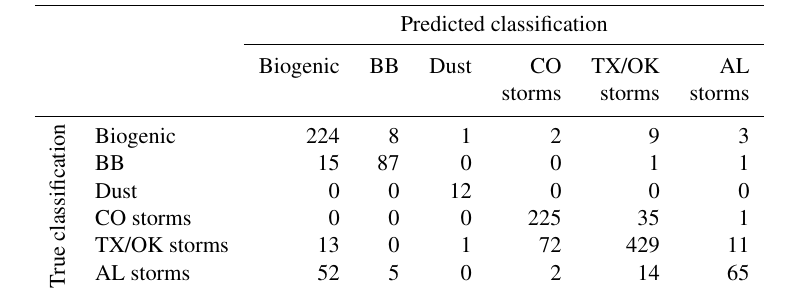
Table 3. Confusion matrix comparing the results of the prediction technique based on Mahalanobis distance for the case in which the first three e F 11 and first − F 12 /F 11 principal component scores are used (corresponding to the last column of Table 2) against the actual classification results of the ancillary data classification scheme. Several rows of the table sum to slightly less than the number of cases shown in Table 1 because PCA scores could not be calculated for averages containing nonphysical measurements at one or more